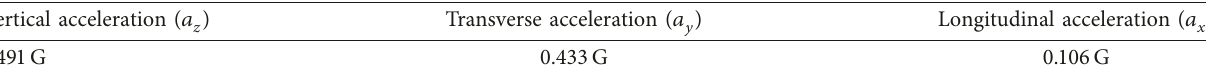
Table 4: Calculated results of